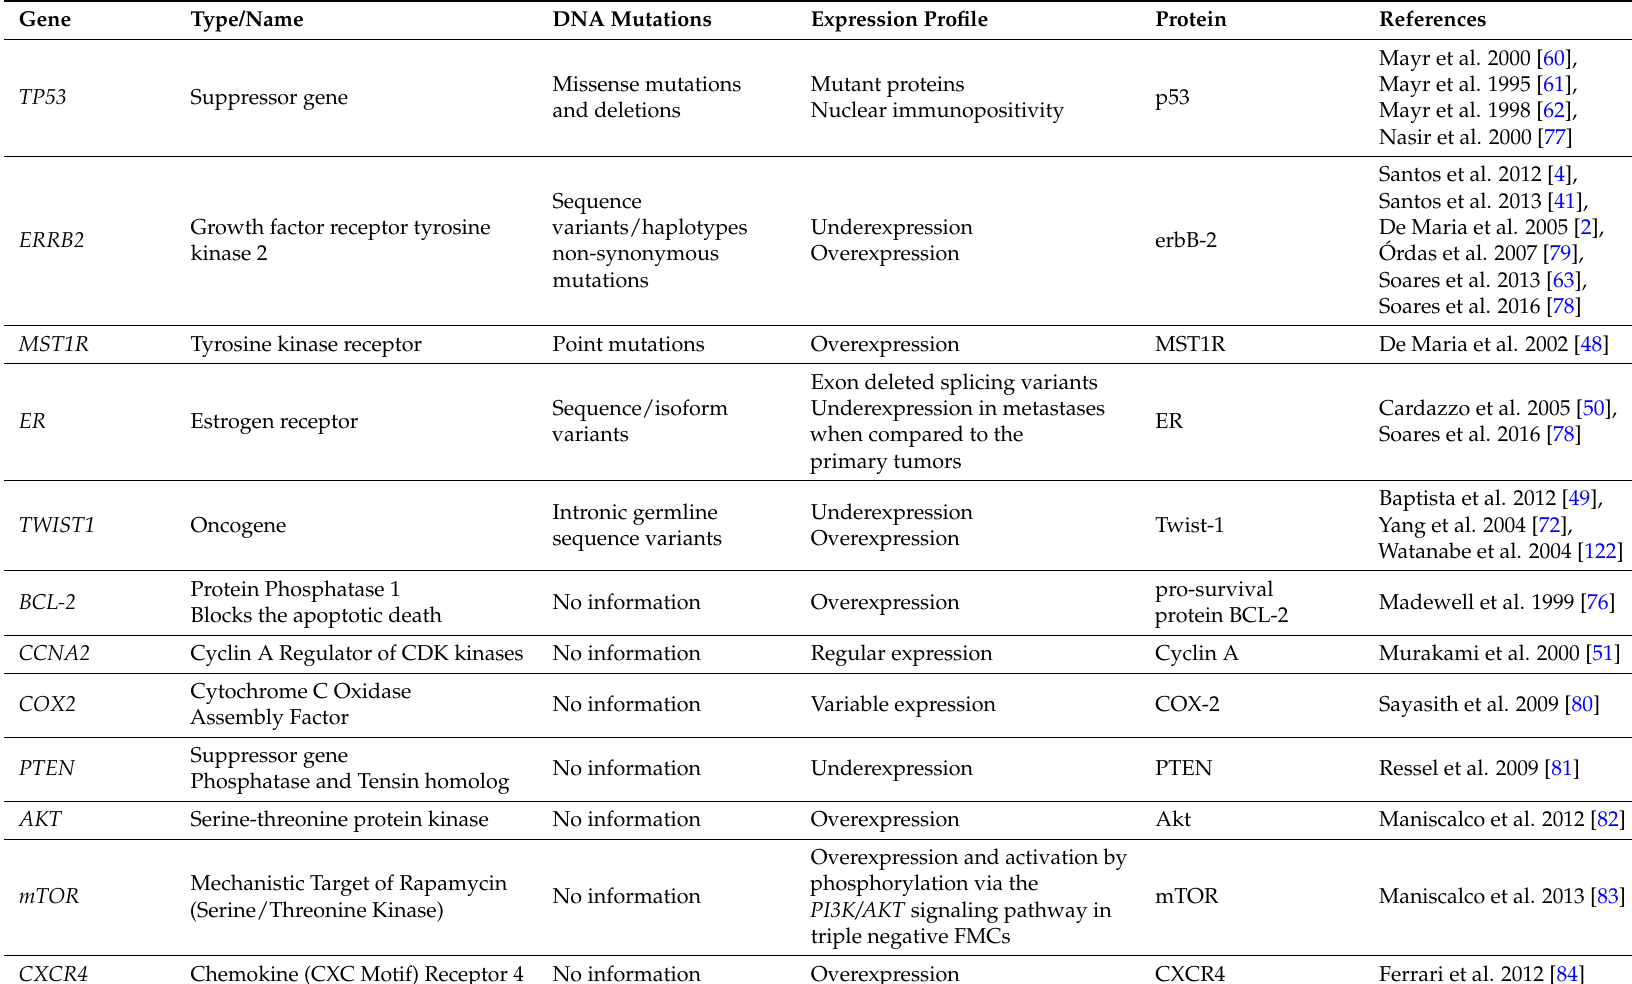
Table 1. This table summarizes the critical cancer genes already analyzed in feline mammary